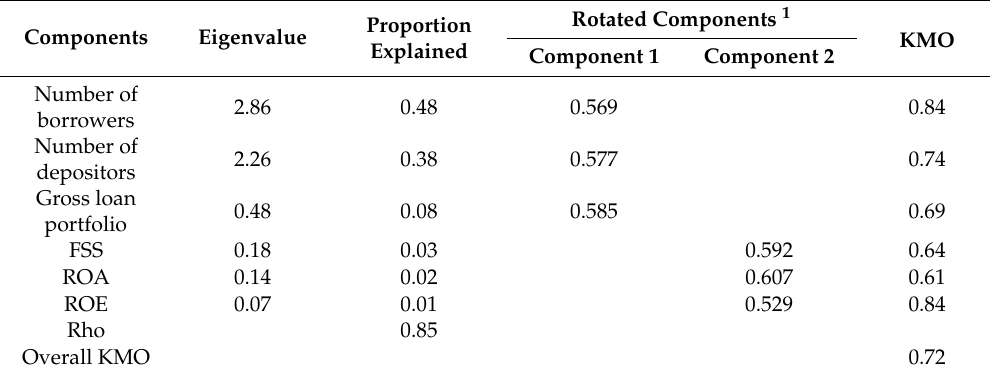
Table A2. PCA estimates and diagnostics tests.